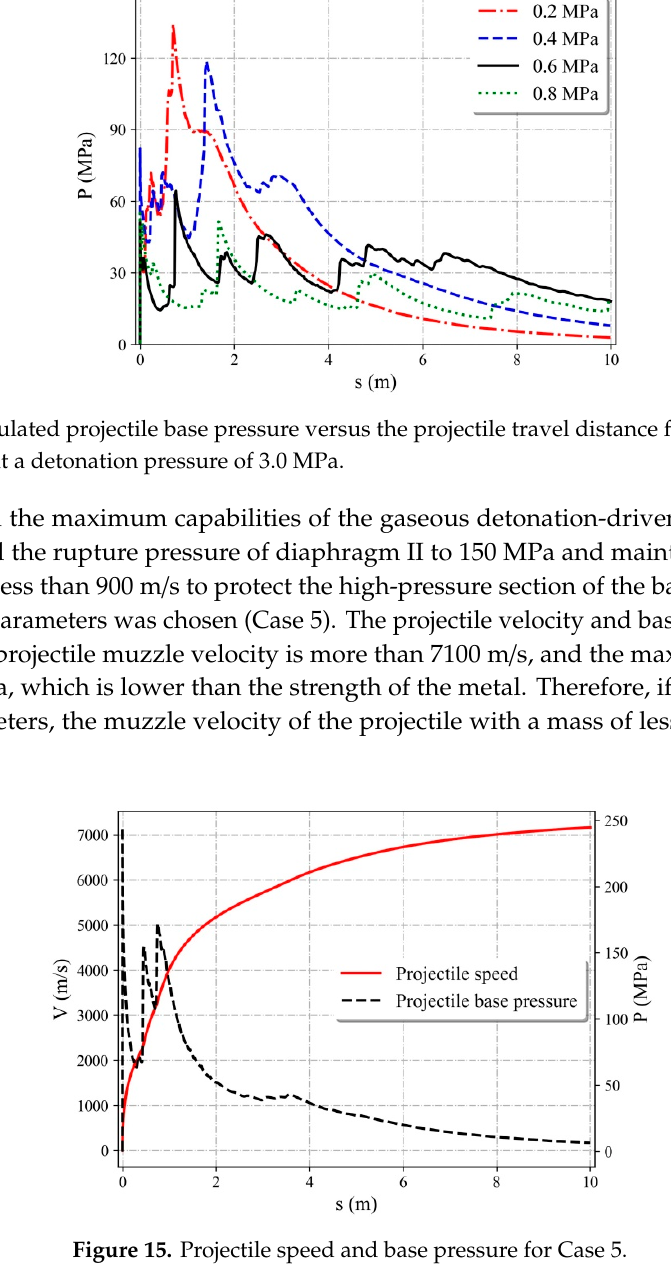
Figure 13. Simulated results at different detonation pressures. ( a ) maximum piston speed versus the initial pump pressure; ( b ) muzzle projectile speed versus the initial pump pressure.